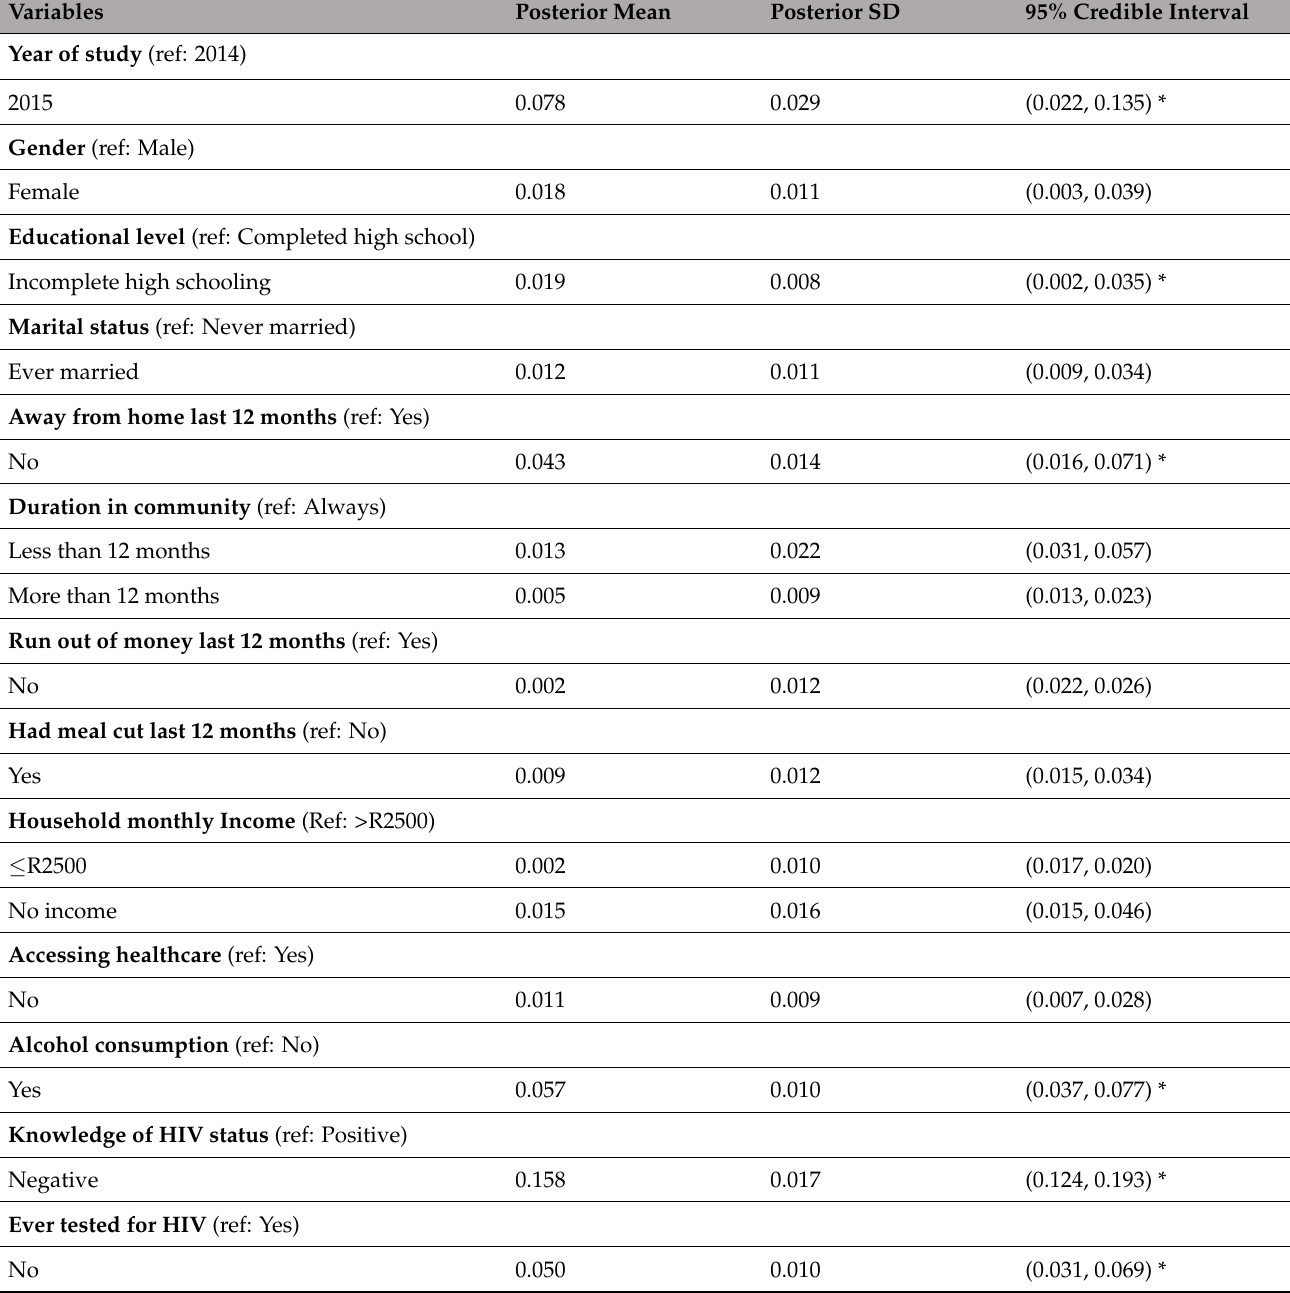
Table 3. Adjusted odds ratio (AOR) estimates and 95% credible intervals for predictors of unsup- pressed HIV viral load among HIV-positive men and women in Vulindlela (rural) and